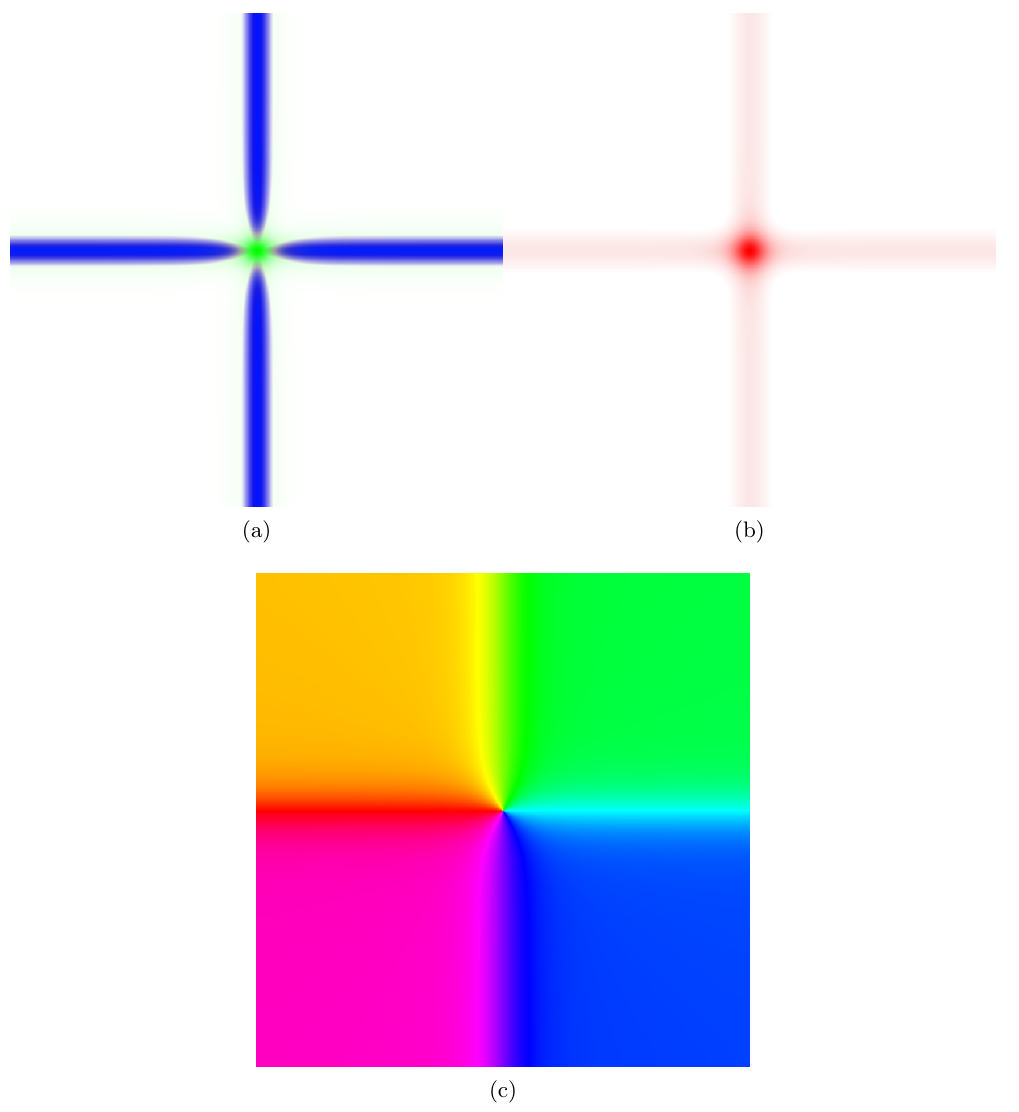
Figure 19 : ( Q global vortex with four angular domain walls: (a) energy 1 ; Q 2 ) = (1 ; 4) density (green) and density of the generalized Josephson term (blue) using the color scheme of (cid:12)gure 2(b); (b) (cid:12)eld density using the color scheme of (cid:12)gure 2(a); (c) arg( (cid:30) 1 ) mapped to the color wheel